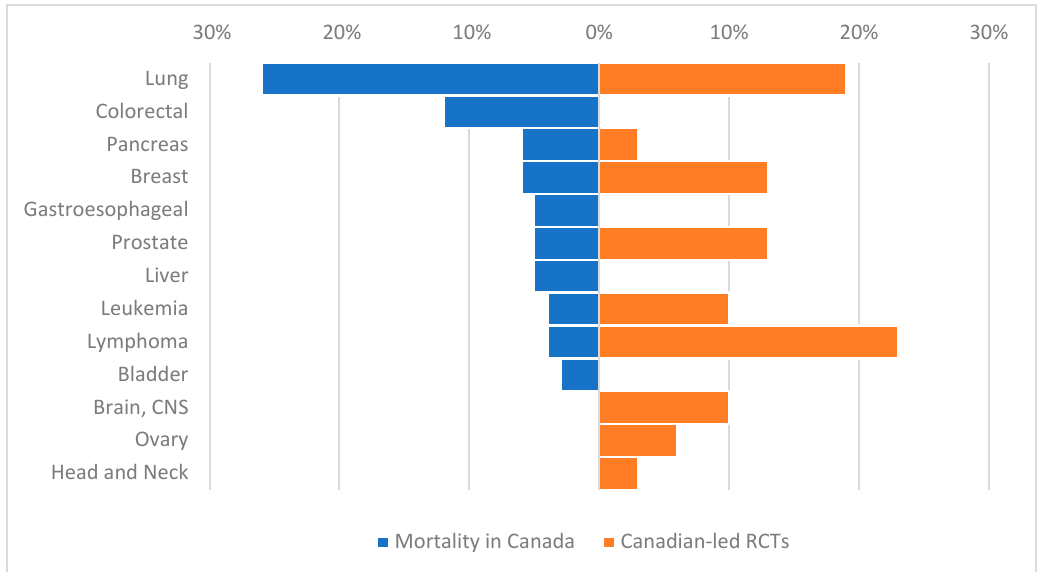
Figure 1. Ranking of top 10 cancers by proportion of all cancer deaths in Canada * and top 10 cancers by proportion of 31 Canadian ‐ led randomized controlled trials published during 2014–2017. * From GLOBOCAN 2018 https://gco.iarc.fr/today/home (accessed on 19 October